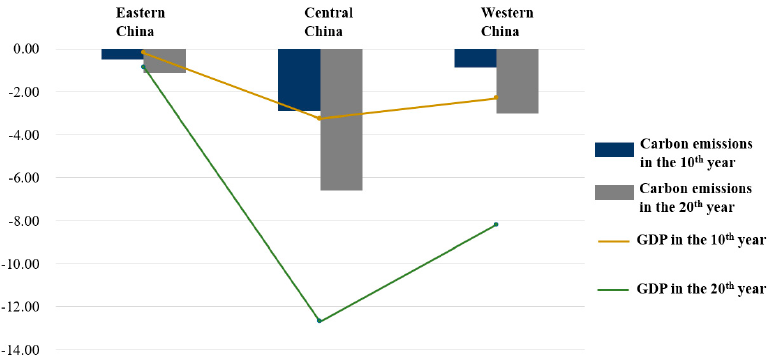
Figure 5. Impacts of the trading mechanism on China’s region carbon emissions and GDP under scenario T in 10th year and 20th year (%).